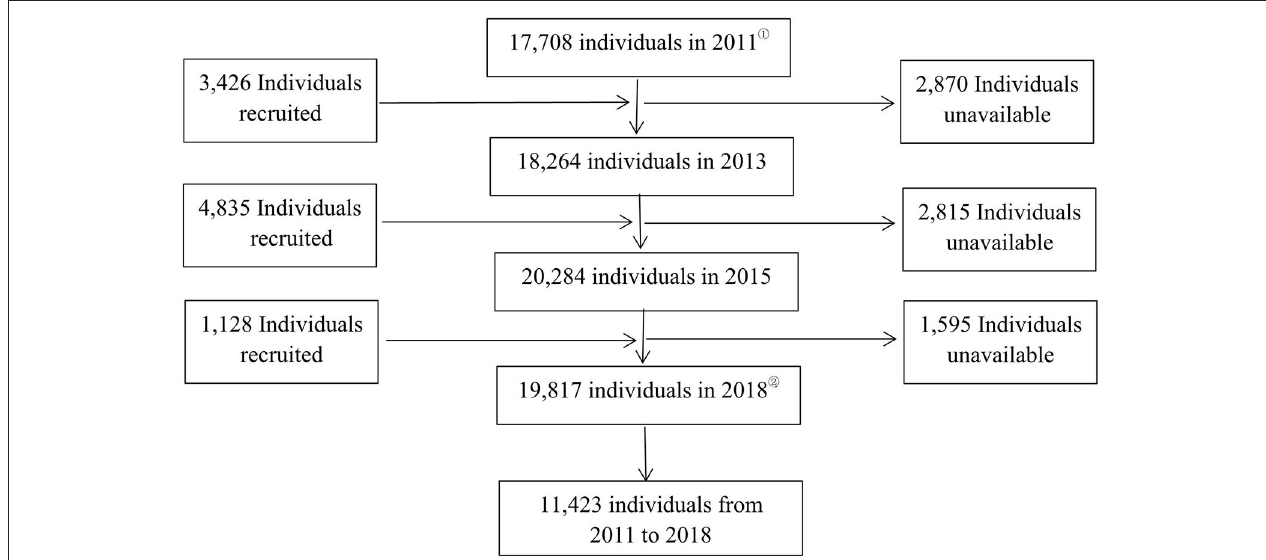
FIGURE 1 | Sampling flowchart. ‹ 2011 is the T(0), › 2018 is the T(n).